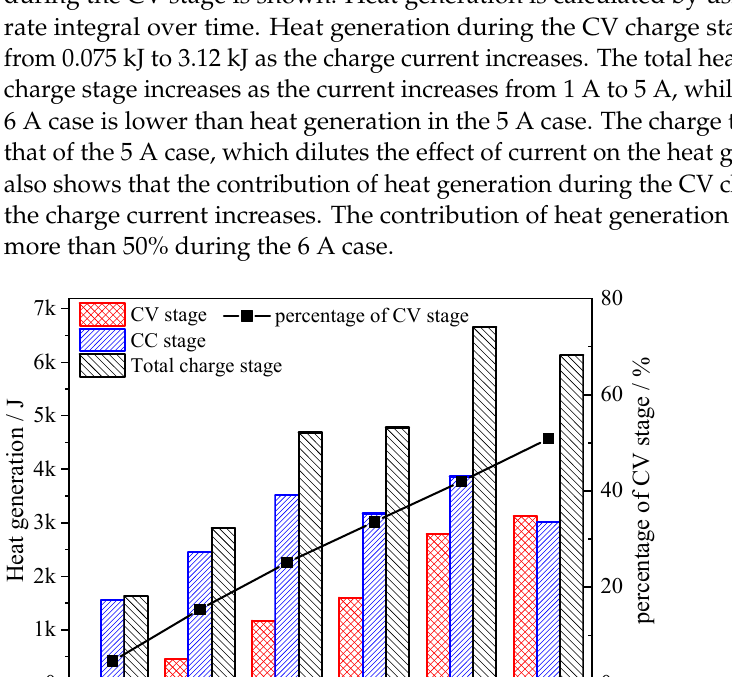
Figure 4. Effect of operating current on heat generation during the discharge stage. Both total heat generation and residual heat generation increase as discharge current, and the contribution of residual heat generation is just 5~6% under the 1 A and 2 A cases, while the value increases to 20% during the 6 A case. This means that as current increases, the heat absorbed by the battery itself is also increasing, which would take more than 1/5 of the total heat generation. The absorbed heat would make a large temperature gradient during battery operation, which causes inhomogeneity and safety problems. Figure 5 shows the relationship between the charge capacity and charge current dur- ing CC, CV, and the total charge stage, respectively. The charge capacities for the six cases are 4.77, 4.41, 4.15, 3.47, 3.46, and 2.78 Ah during the CC charge stage, and 0.34, 0.57, 1.02, 1.41, 1.71. and 2.02 Ah during the CV charge stage, which means that charge capacity during the CC charge stage decreases as current increases, while the charge capacity dur- ing the CV charge stage has an opposite tendency. Total charge capacities are 5.11, 4.98,